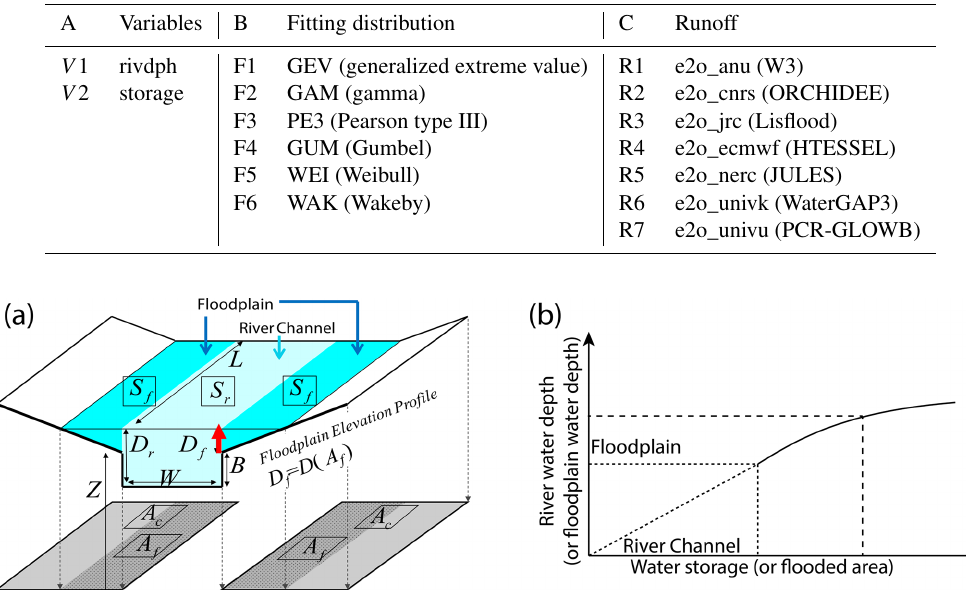
Table 1. Experiments used in this study for uncertainty analysis. There are three groups: (A) the variables for FFA, (B) the fitting distributions and (C) the runoff inputs. Different runoffs are generated by using the same forcing (WFDEI) but with different land surface models or global hydrological models (as specified in the brackets) (Schellekens et al., 2017).